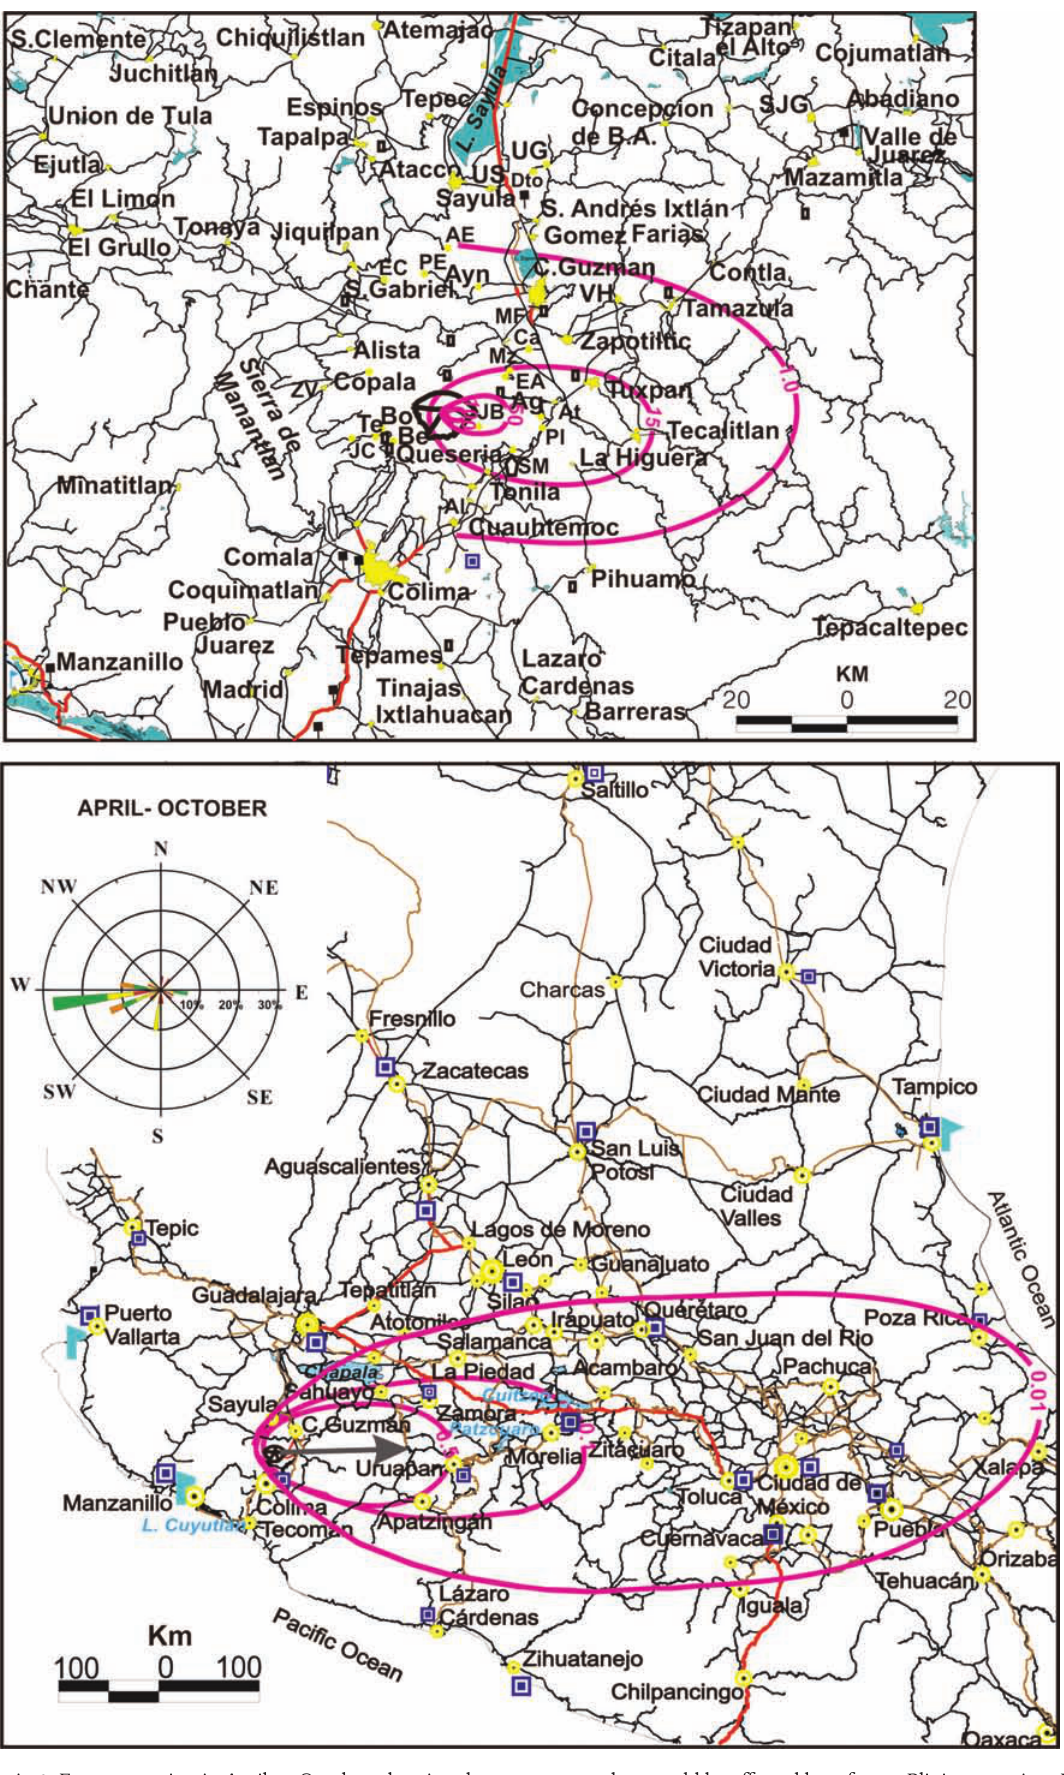
Figure 5. Scenario 2. For an eruption in April or October, showing the eastern area that would be affected by a future Plinian eruption. For details, see legend to Figure